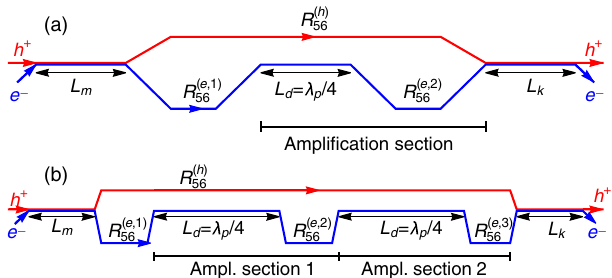
FIG. 1. Schematic of the microbunched electron cooling system: (a) with one amplification section and (b) with two amplification sections. The blue lines show the path of the electron beam, and the red lines indicate the trajectory of the hadron